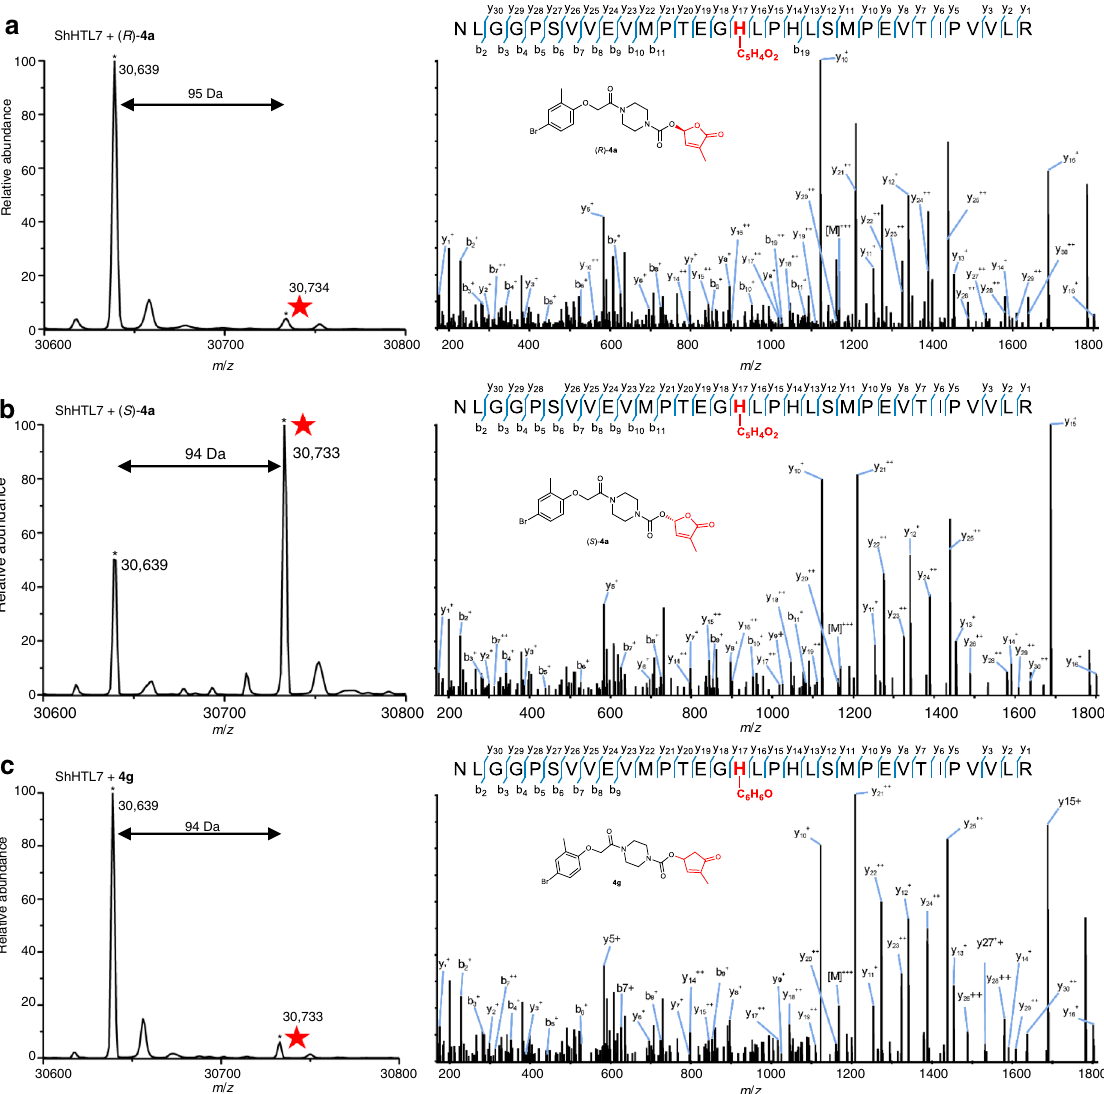
Fig. 3 Analysis of the potential covalent modi fi cation on His246 of the catalytic triad. a – c LC-MS analysis of the full-length protein (left) and LC-MS/MS analysis of the modi fi ed peptide (231-NLGGPSVVEVMPTEGHLPHLSMPEVTIPVVLR-262) (right) of ShHTL7 treated with ( R ) − 4a ( a ), ( S )- 4a ( b ), and 4g ( c ), respectively. The modi fi ed peptide at m / z = 30,734 or 30,733 on the left panels together with the MS2 spectrum on the right suggested that C 5 H 5 O 2 ( a , b ) or C 6 H 6 O ( c ) was modi fi ed on the His246 of the catalytic triad, respectively. Labelled peaks on the right panels correspond to masses of y and b ions of the modi fi ed